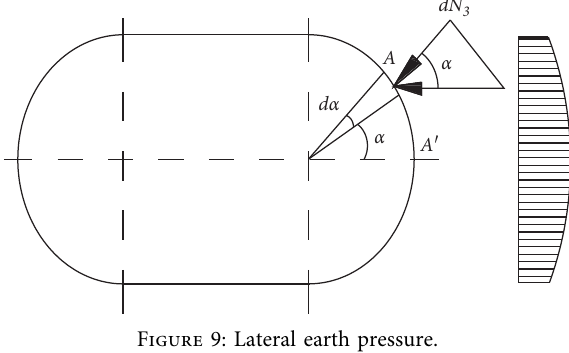
Figure 9: Lateral earth Table 2: Technical parameters of the quasirectangular shield. Technical parameters Figure 8: Vertical earth pressure.